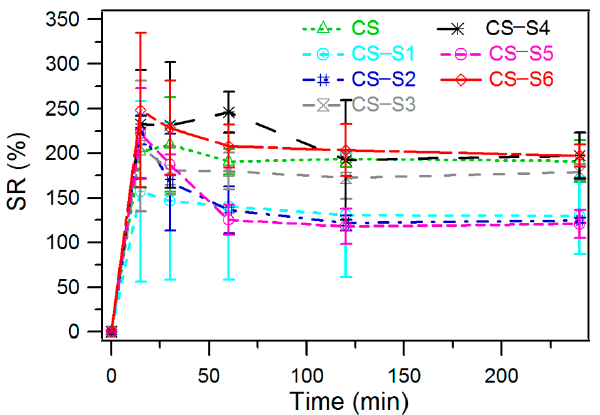
Figure 6. Swelling ratio of chitosan-derivative films.